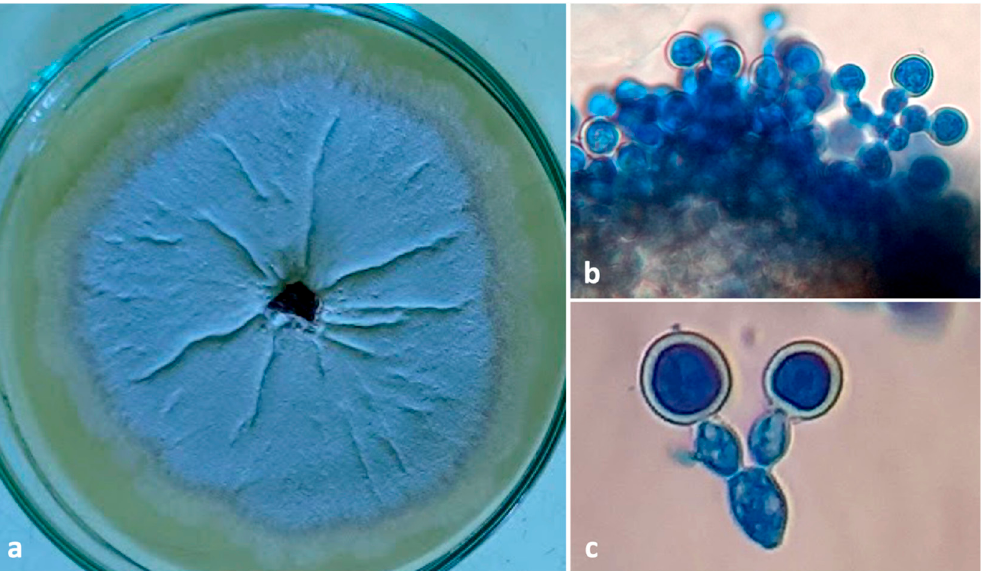
Figure 7. ( a ) Culture plate of Ambrosiella roeperi ; ( b ) sporodochial mass A. roeperi isolated from mycangia; ( c ) branched conidiophore with terminal aleurioconidia.